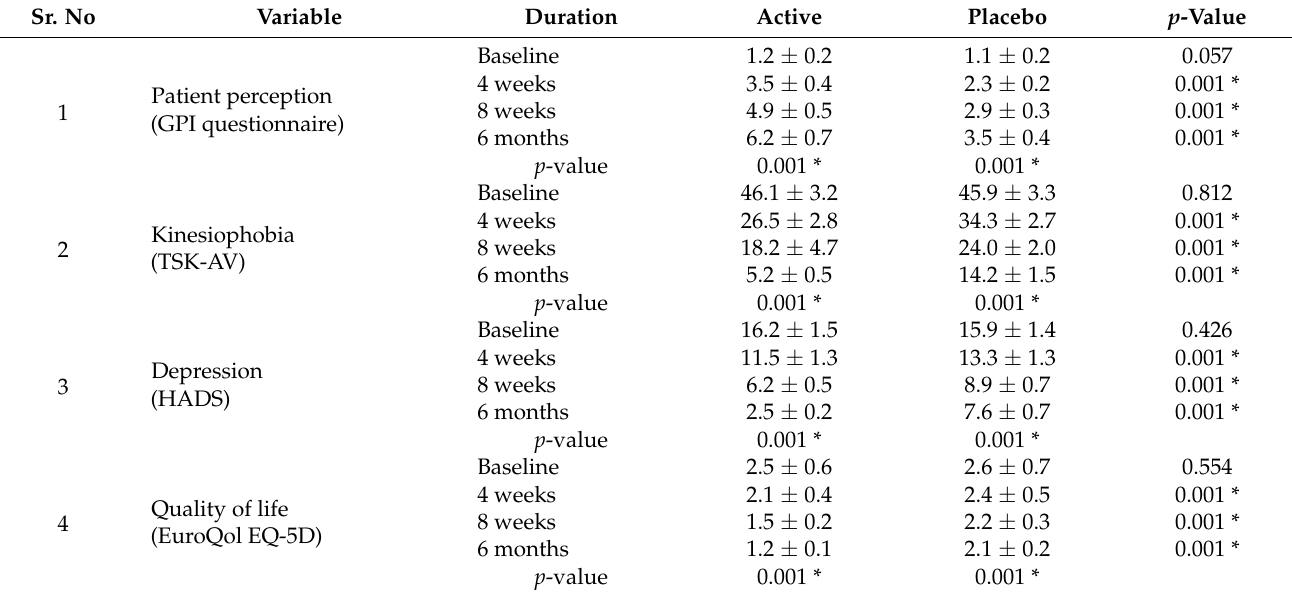
Table 3. Pre- and post-secondary outcome measures of active and placebo ESWT groups.